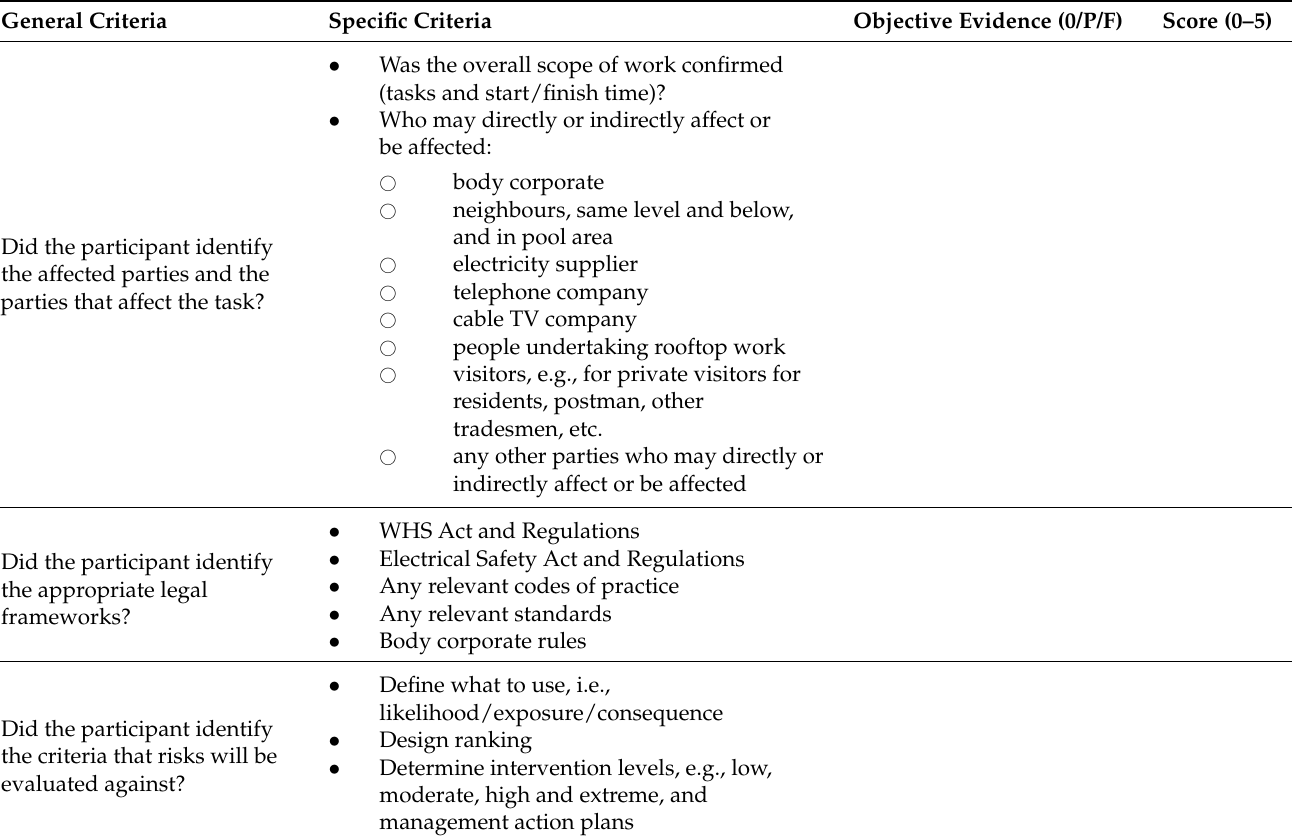
Table 1. Criteria for E1 “establishing the